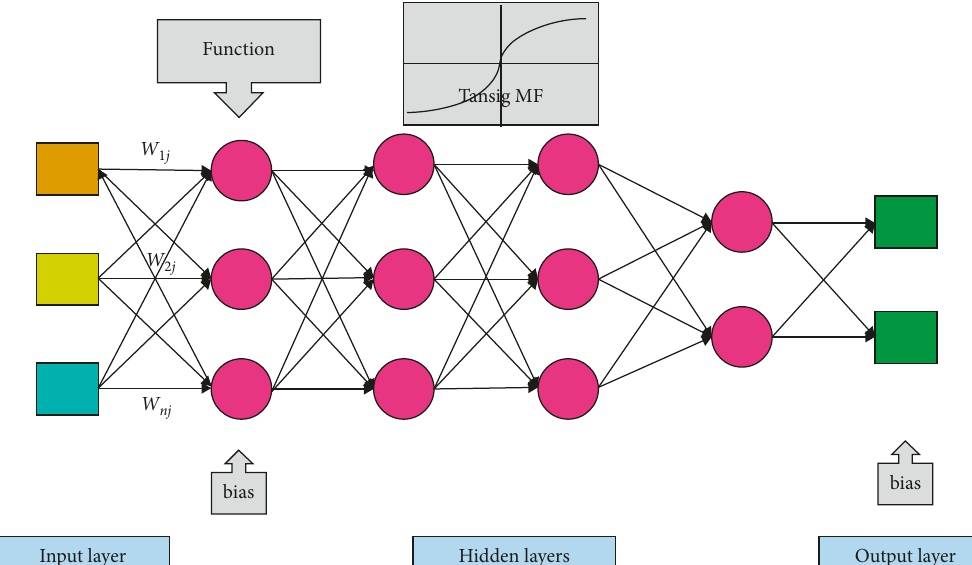
Figure 1: The architecture of the constructed DLNN